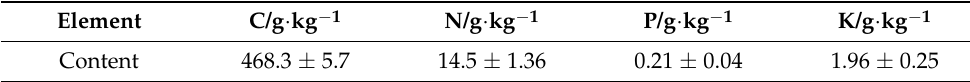
Table 1. Contents of main nutrient elements in Melaleuca alternifolia residues.